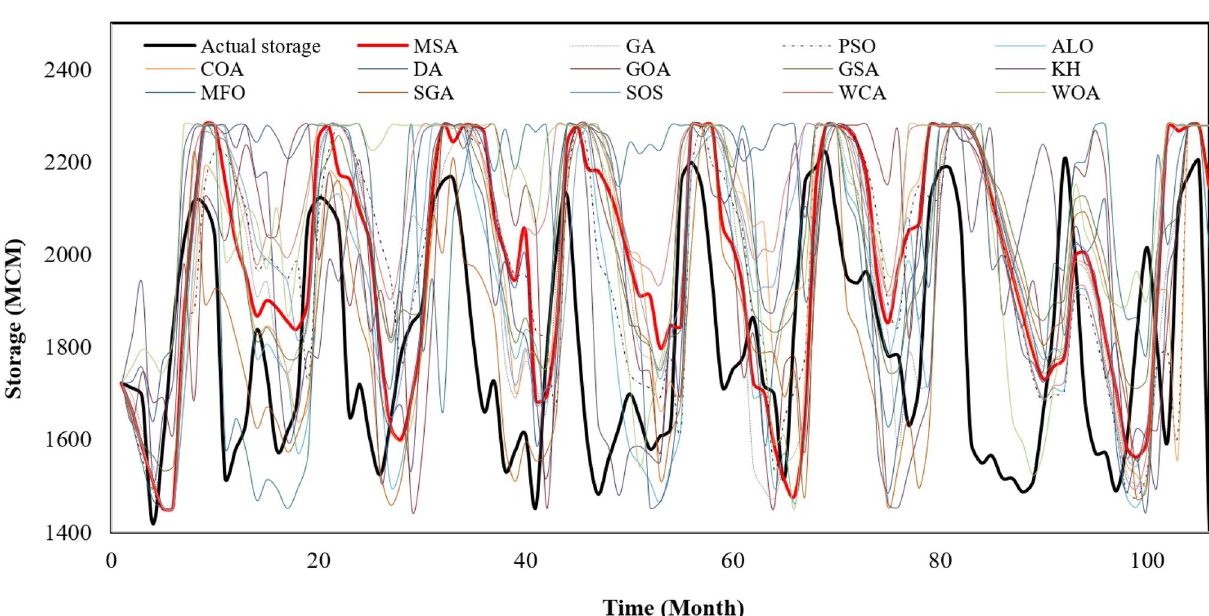
Figure 4. The actual power generation patterns of Karun-4 hydropower reservoir vs. predicted values by the algorithms.